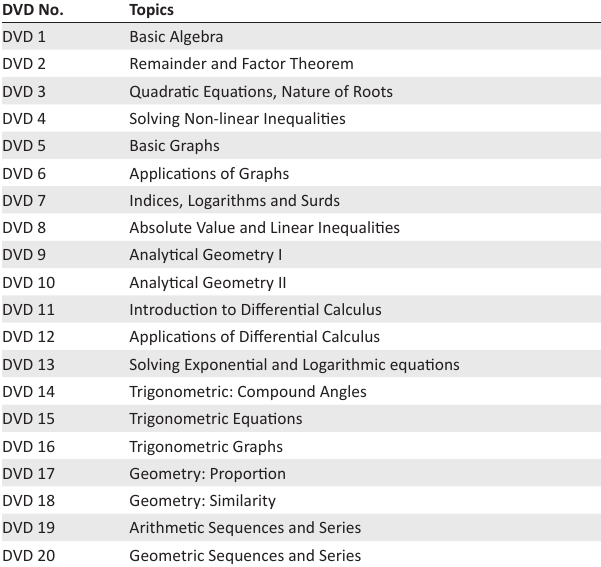
TABLE 2: The 20 mathematics DVD